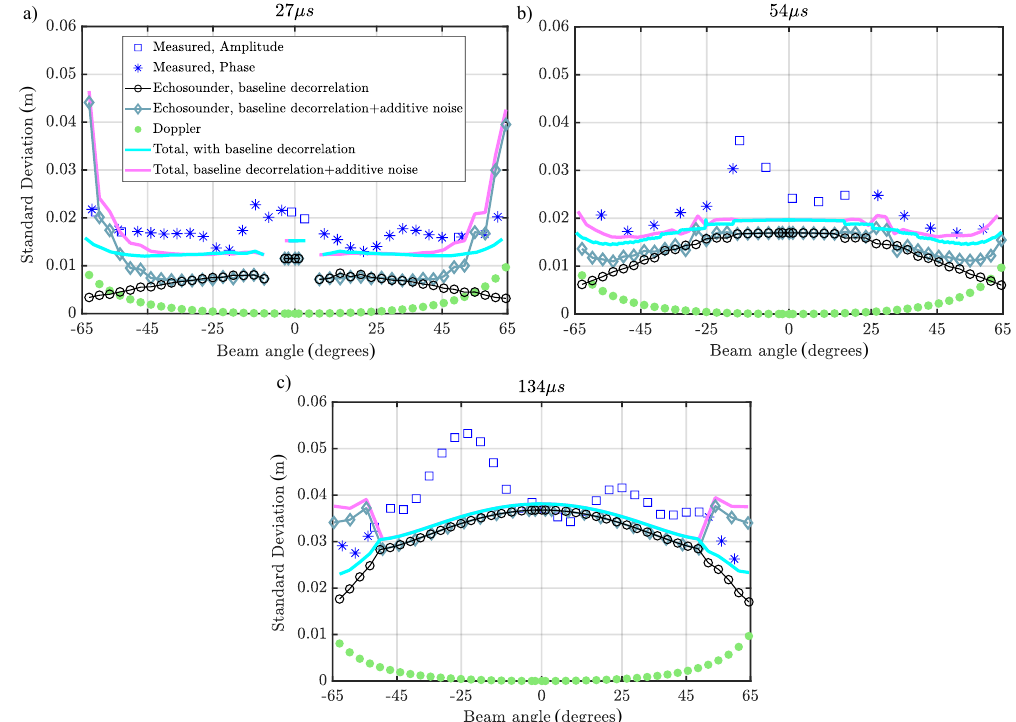
Figure 7. Bathymetric uncertainty derived from the measurements (blue) and those predicted considering the uncertainty induced by the Doppler effect and baseline decorrelation without (cyan) and with (light pink) additive noise for a water depth of 10m and a pulse length of ( a ) 27µs, ( b ) 54µs, and ( c ) 134µs. The change from amplitude to phase detection is shown by switching from square markers to asterisks with the same color. The location of this switch was similarly applied in the modeling. The depth uncertainty induced by motion sensor measurements, correction accuracy for misalignment, sound speed, and heave are equal to those of Figure 5 and are thus not shown